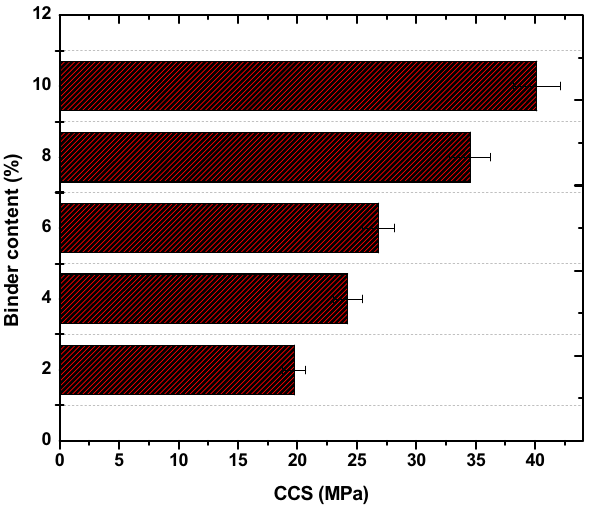
Figure 4. CCS of the fuel briquettes.